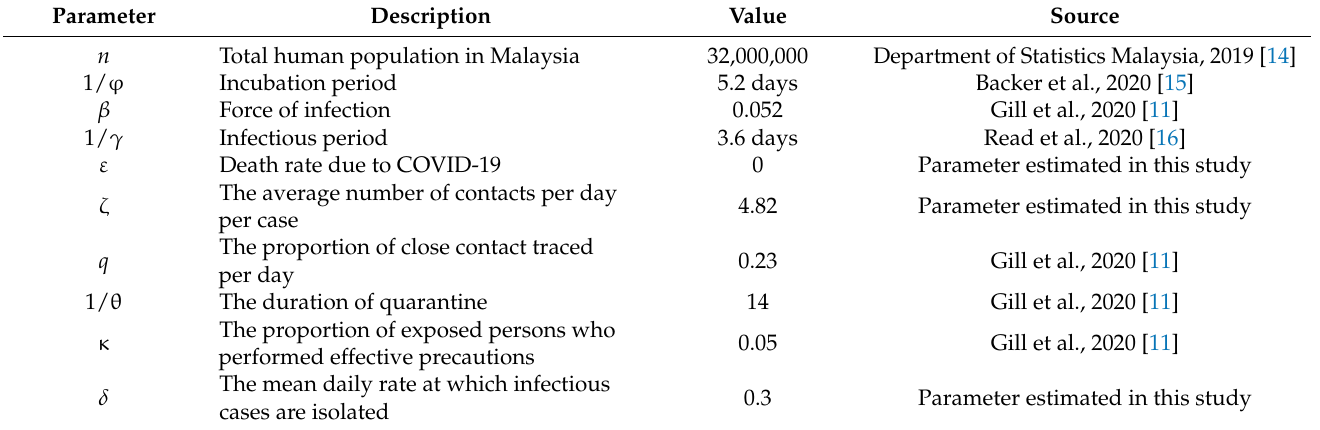
Table 1. Parameters and the respective values used in the SEIR model for the first COVID-19 wave in